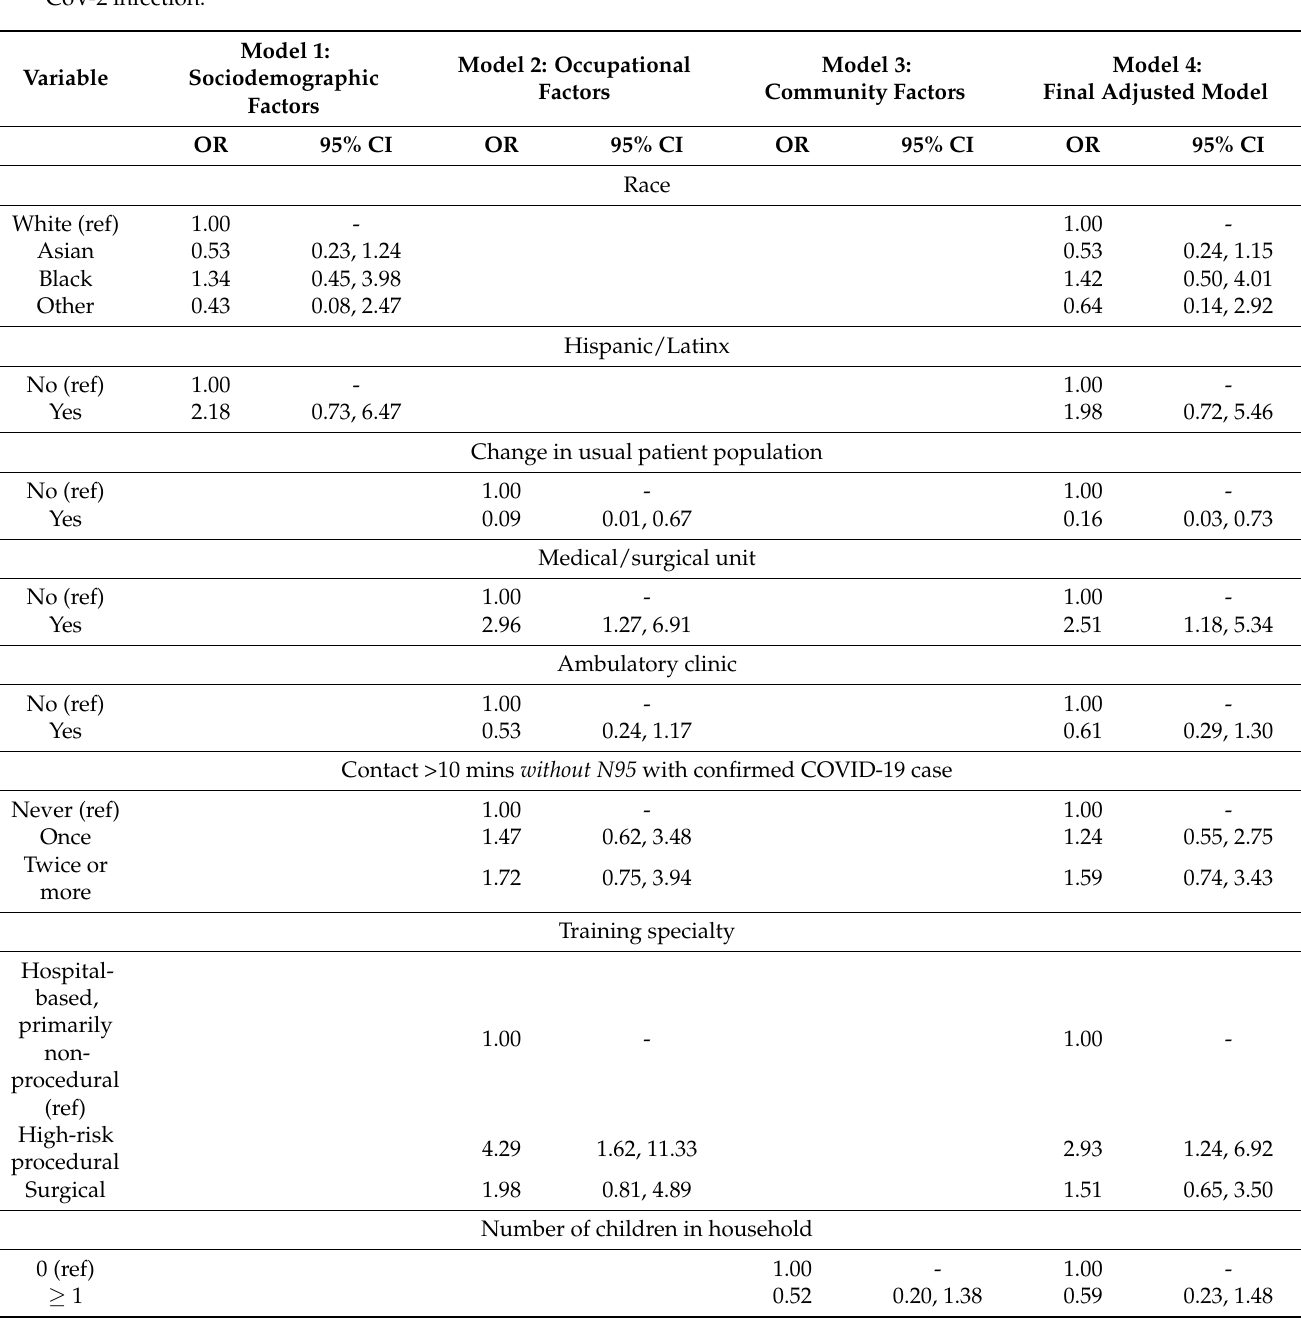
Table 2. Adjusted effect estimates for associations of sociodemographic, occupational and community factors with SARS- CoV-2